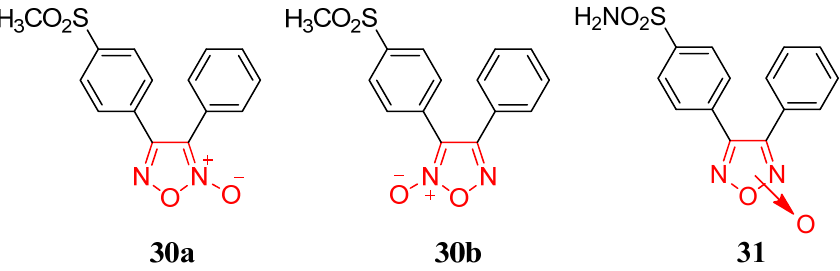
Figure 20. COX-2 inhibitors (black)/NO donor (red) hybrid